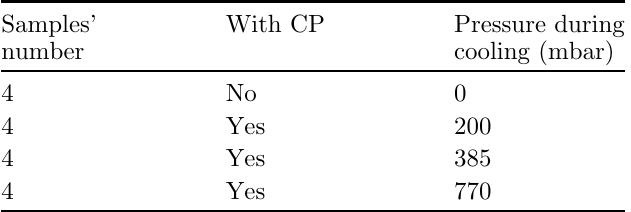
Table 4. Peeling process manufacturing parameters. CP stands for Cooling Press.